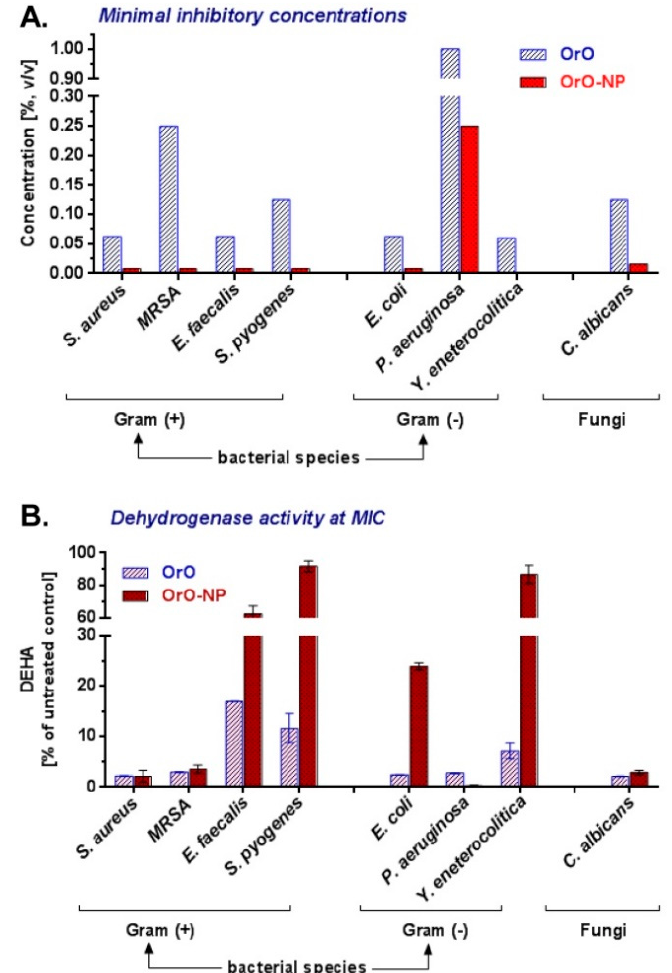
Figure 4. Minimal inhibitory concentrations and dehydrogenase activity at MIC of the oregano